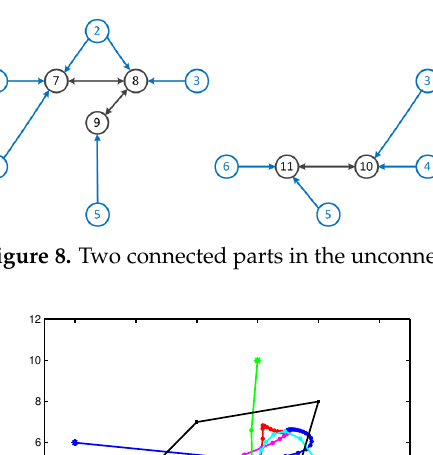
Figure 7. Unconnected topology of the agents